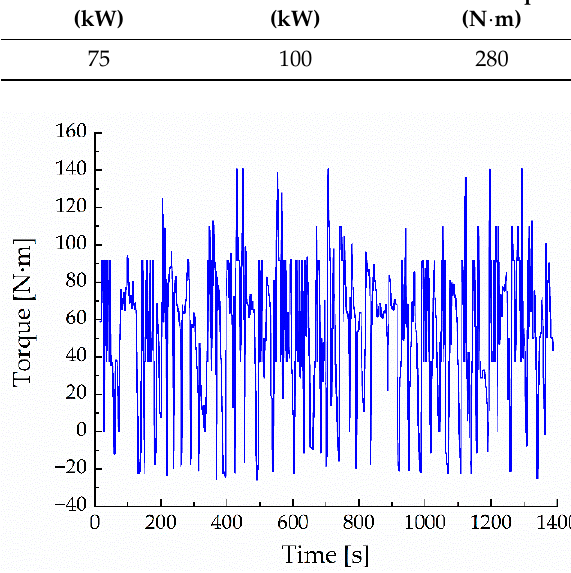
Figure 7. Electromagnetic braking torque–time history.